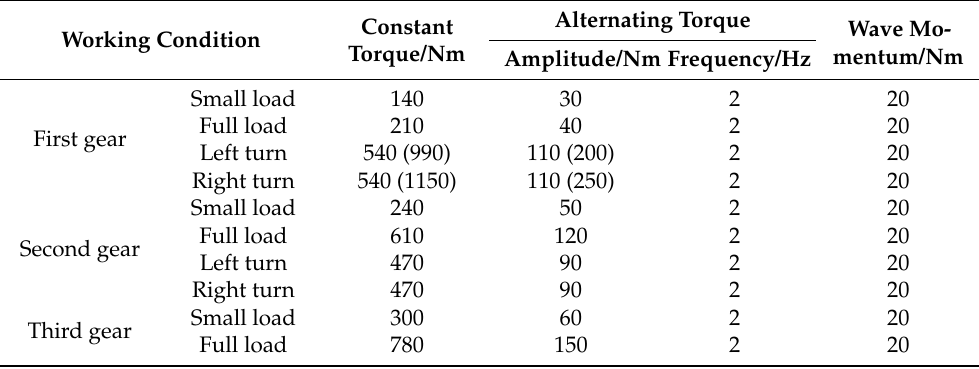
Table 8. Torque loading